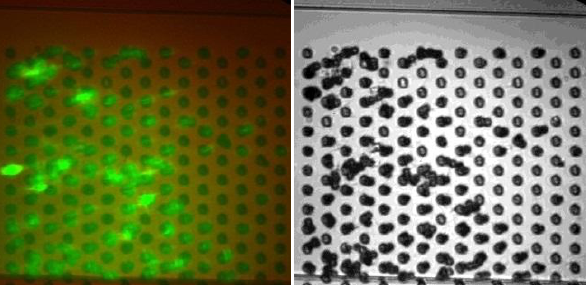
Figure 9. Capturing performance of rotating magnetic beads. The fluorescence in the image is the presence of biotin-labeled Fluospheres (Invitrogen) bound to the M-280 microbeads after the flow. The image on the right is the brightfield image showing the positions of the M-280